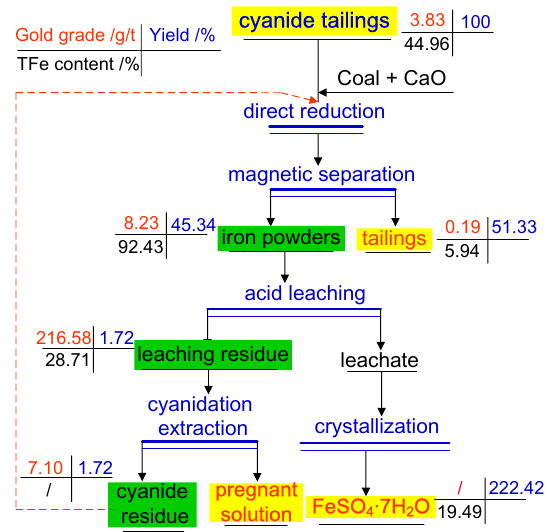
Figure 2. Flowsheet for the recovery of gold and iron from cyanide tailings at the reduction temperature of 1200 °C. (The Yield is defined as the weight percentage of solid products to received cyanide tailings as shown in Equation (5)).